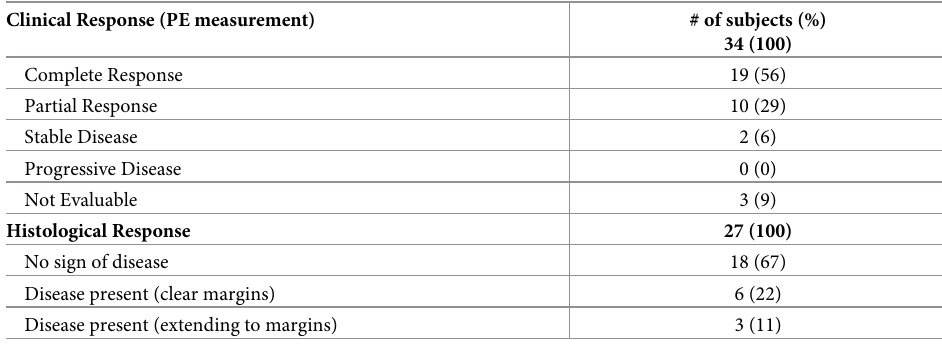
Table 2. VISORB study outcomes